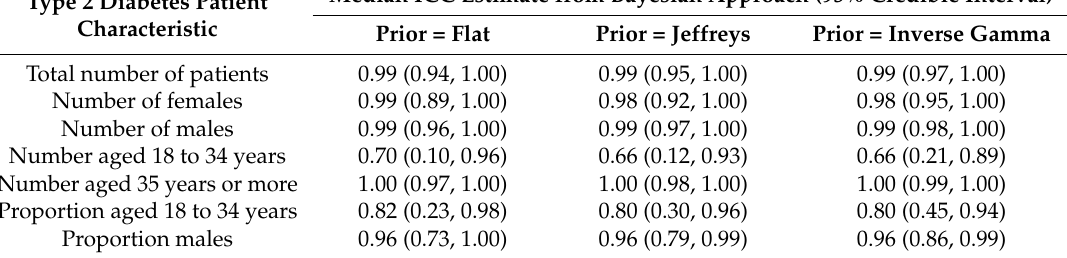
Table 1. Intra-class correlation estimates of concordance between PenCAT and Communicare data for each service regarding the total number and proportion of patients with diabetes including by gender and